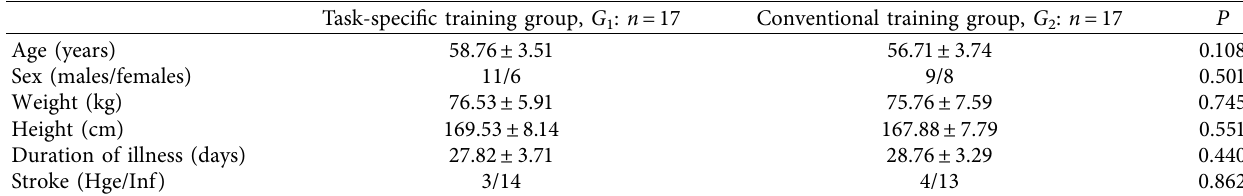
Table 1: Subjects’ characteristics. Task-specific training group, G 1 : n � 17